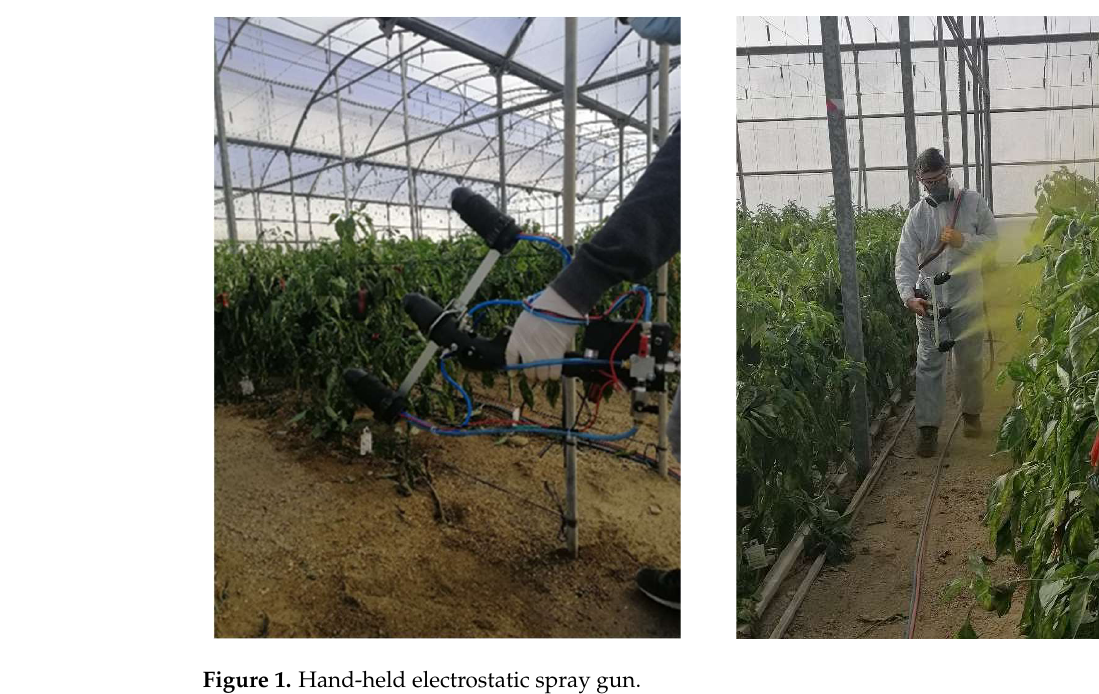
Figure 1. Hand-held electrostatic spray gun.